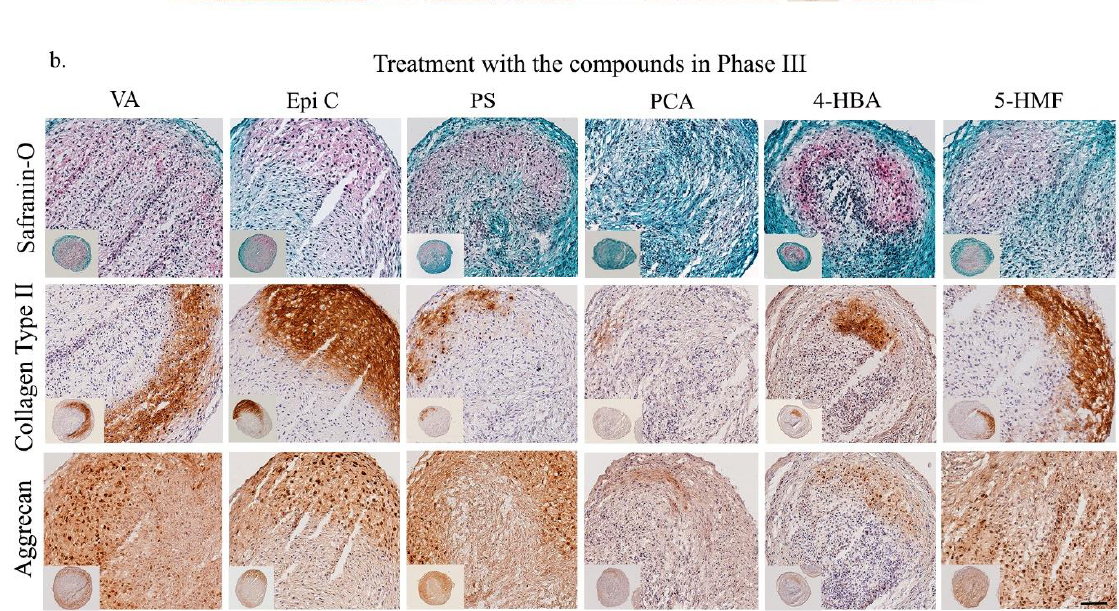
Figure 4. Histological and immunohistochemical characterization of pellets from OA chondrocytes in the inflammatory model (long term). a ) Saf-O staining, COL-II and ACAN immunostaining of pellets in three different phases as the control groups (Phase I, Phase II, Phase III). b ) and after 14 days of treatment with the TCM compounds in phase III (VA, Epi C, PS, PCA, 4-HBA, 5-HMF). Scale bars = 100 µ